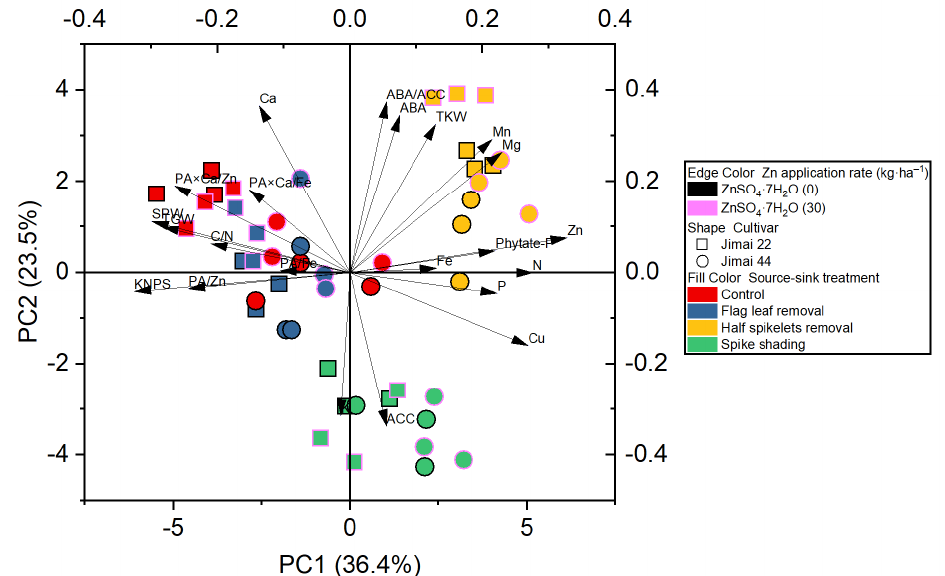
Figure 2. Principle component analysis (PCA) of the effect of source–sink manipulation on various investigated parameters of wheat plants. The abbreviations are as follows: single panicle weight (SPW), kernel number per spike (KNPS), thousand kernel weight (TKW), total grain weight (TGW), concentrations of abscisic acid (ABA), the ethylene precursor 1-aminocylopropane-1-carboxylic acid (ACC), Zn, Fe, Mn, Cu, N, P, K, Ca, Mg and phytate-P, ratios of C/N and ABA/ACC, and molar ratios of phytic acid (PA)/Zn, PA × Ca/Zn, PA/Fe and PA × Ca/Fe in wheat grains.